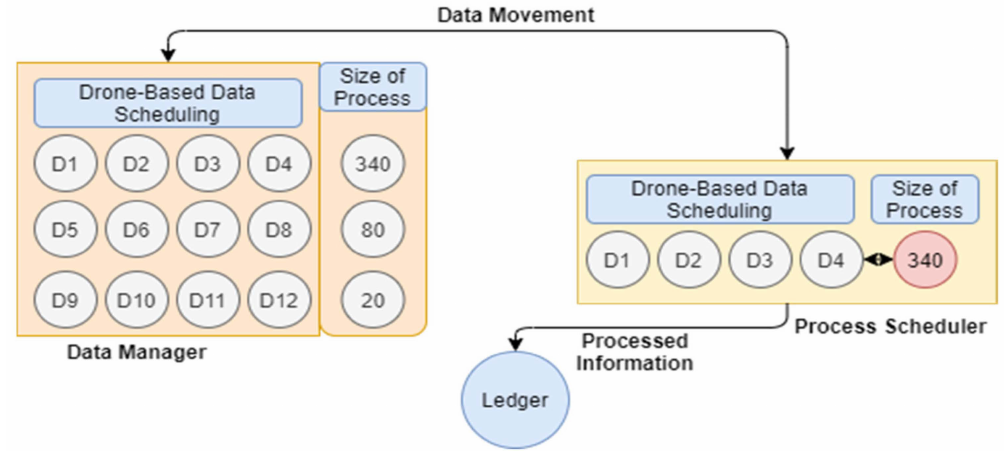
Figure 3. Process Distribution and